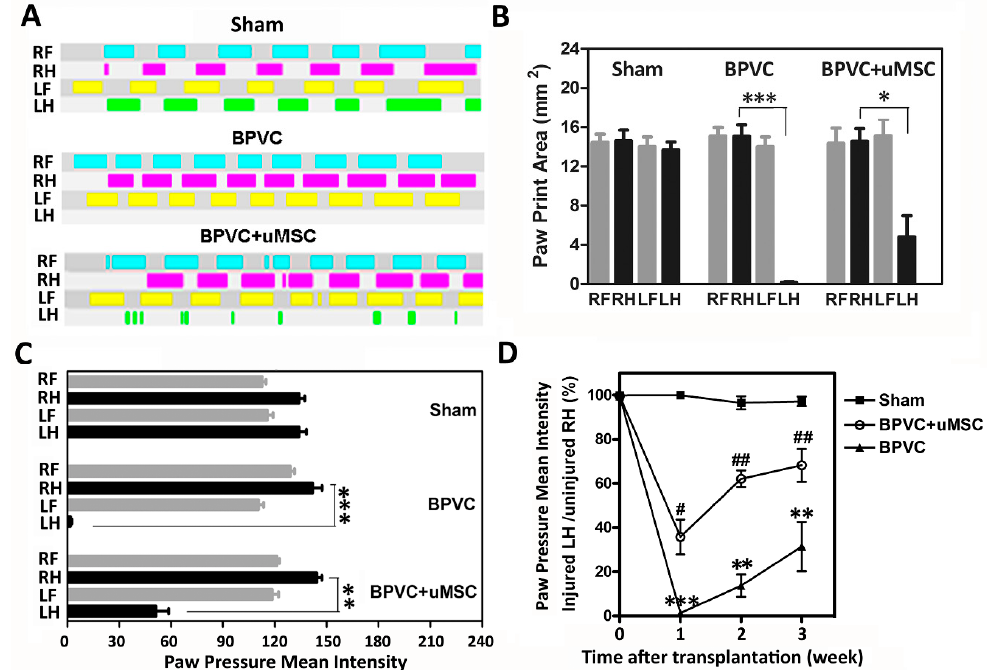
Figure 3. Bupivacaine hydrochloride (BPVC) induced quadriceps muscle necrotic injury and functional impairments, whereas transplantation of uMSCs mitigated the progressive loss of functionality of muscle in vivo. We injected 60 µ L of 1.5% ( w / v ) BPVC into left hind (LH) limb quadriceps muscles of C57BL / 6 mice to induce muscle necrosis (BPVC group). Injection of an equal volume of the saline into the right hind (RH) limbs quadriceps muscles served as the contralateral control. For mice in the sham control group (Sham), quadriceps muscle of both LH and RH limbs received a saline injection. Intramuscular injections of 5 × 10 5 uMSCs in 60 µ L of saline were performed one day post BPVC injury (BPVC + uMSC). ( A ) Representative picture of the CatWalk gait diagram three days after saline injection and BPVC injection, as well as three days after uMSC injection post BPVC injury. Indicated are the paw–floor contacts for each of the paws over time. (RF, right front paw; RH, right hind paw; LF, left front paw; LH, left hind paw). Assessment of gait parameters using the CatWalk system, including ( B ) paw print area and ( C ) paw pressure mean intensity as a measure of functional impairment after three days of saline or BPVC injection, and three days of uMSC injection post BPVC injury. Data are reported as means ± SD; ** p < 0.01, *** p < 0.001 for BPVC-injured LH limb vs. the contralateral uninjured control RH limb ( n = 6 mice / group). ( D ) Progressive paw pressure mean intensities of the injured LH limbs of the three groups were recorded one, two, and three weeks later. The value of intensity for a mouse’s LH paw was normalized to the intensity value (100%) of its contralateral RH paw control ( n = 6 mice / group); * p < 0.05, ** p < 0.01, *** p < 0.001 for BPVC group vs. sham group; # p < 0.05, ## p < 0.01 for BPVC + uMSC group vs. BPVC group.